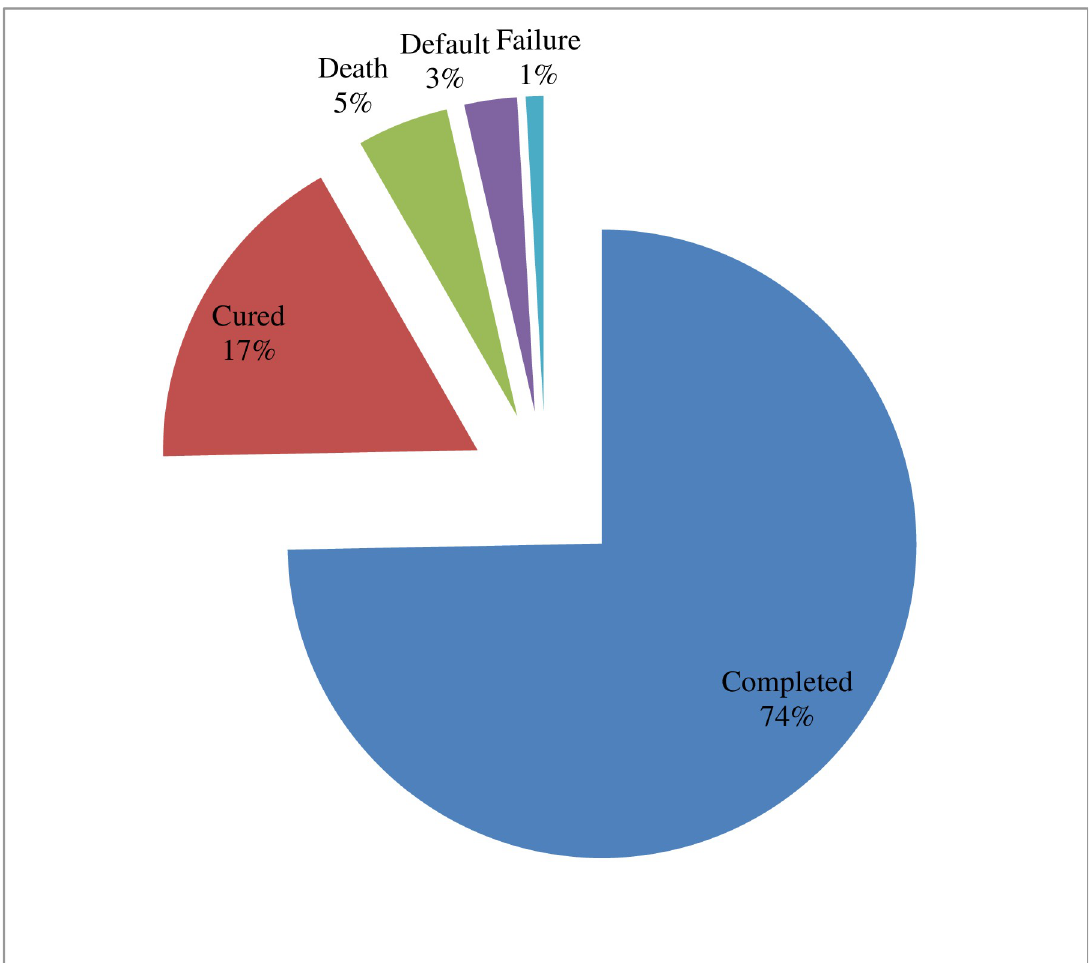
Fig 3. Treatment outcomes of TB patients at three TB treatment centers in East Wollega from 2012 to